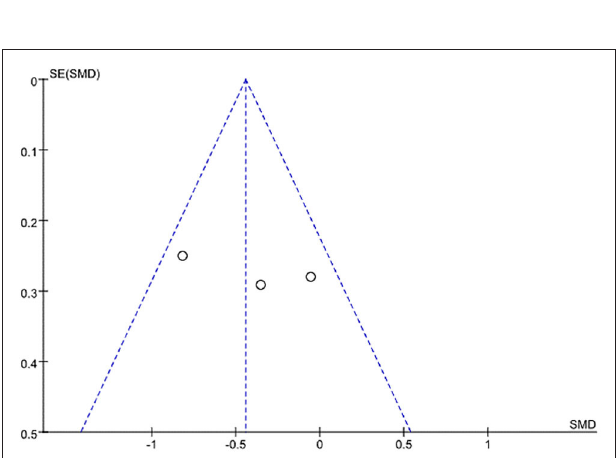
FIGURE 4 | Graphic funnel plot of three studies [Braga et al. (24), Kitano et al. (20), and Zucchi et al.’s (25) studies] depicting differences of 6-month amyotrophic lateral sclerosis functional rating scale (ALSFRS)-Total